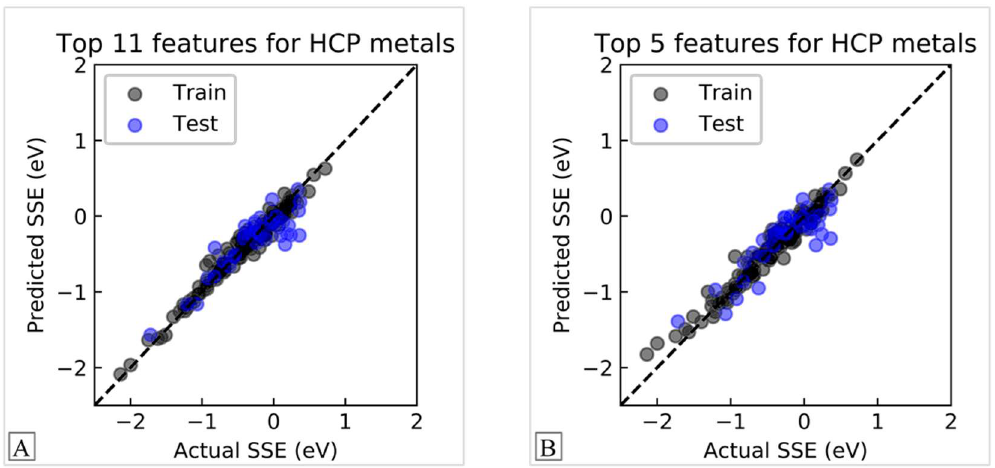
Figure 7. GBR model predictions for HCP(001) surfaces using ( A ) 11 features and ( B ) 5 features. SSE = surface segregation energy. surface segregation